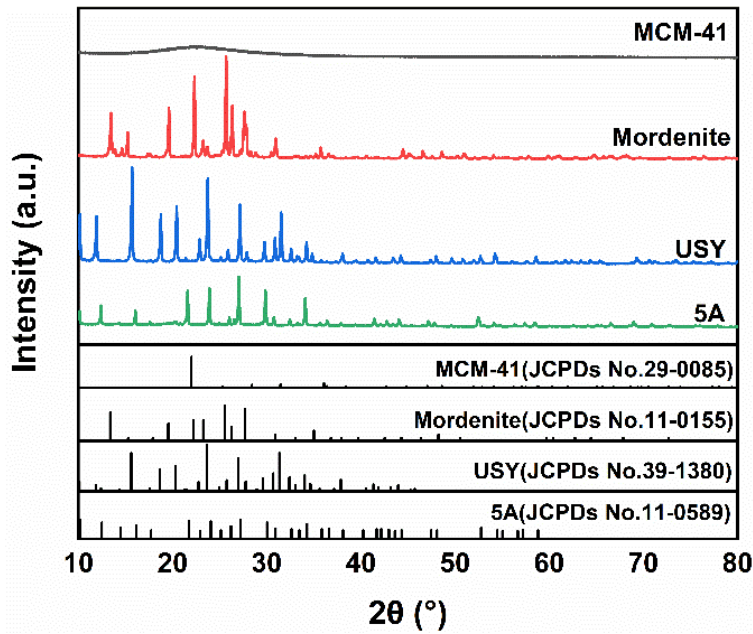
Figure 1. XRD patterns of the V/M (M = MCM-41, mordenite, USY and 5A) catalysts.